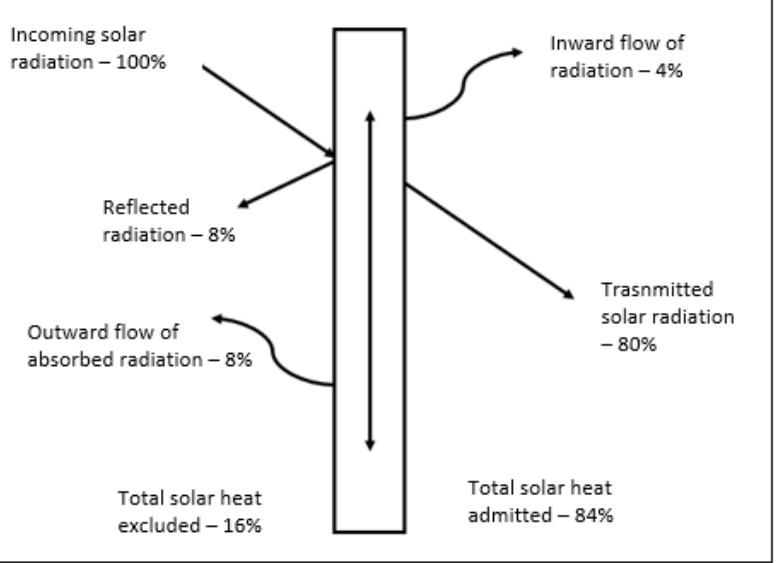
Figure 2. Solar Radiation on a Window; regenerated [8].